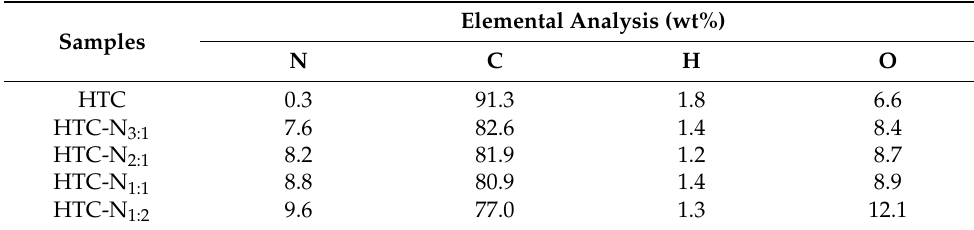
Table 2. Elementary compositions of the carbon